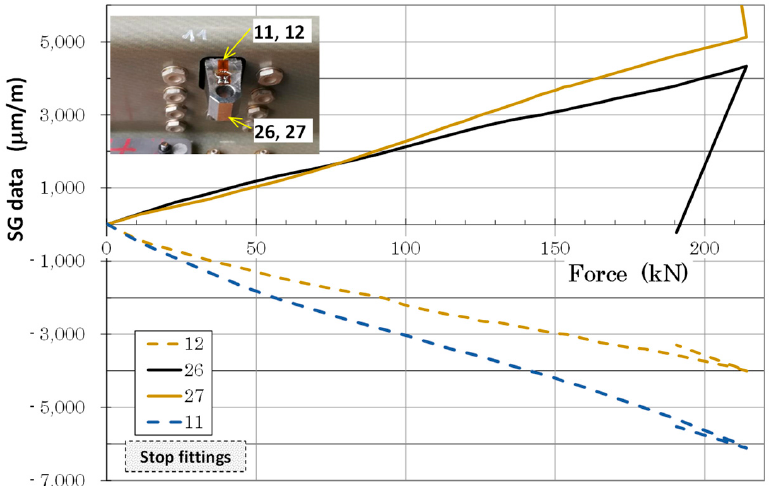
Figure 17. SG data and stop fittings up to door panel failure.